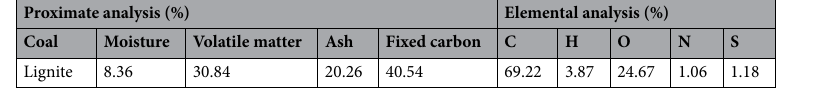
Table 1. Proximate analysis.